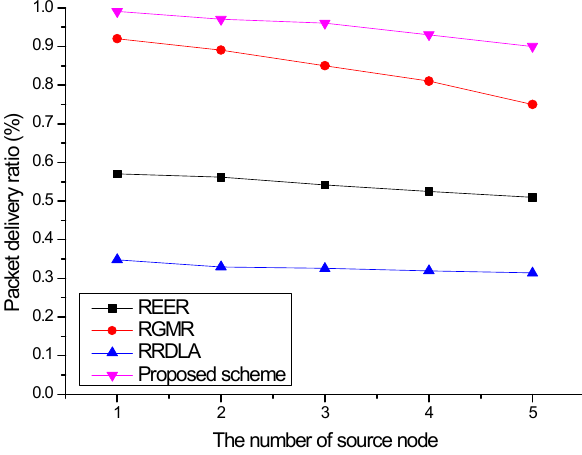
Figure 10. Packet delivery ratio vs. the number of source nodes with 90% of the link reliability.